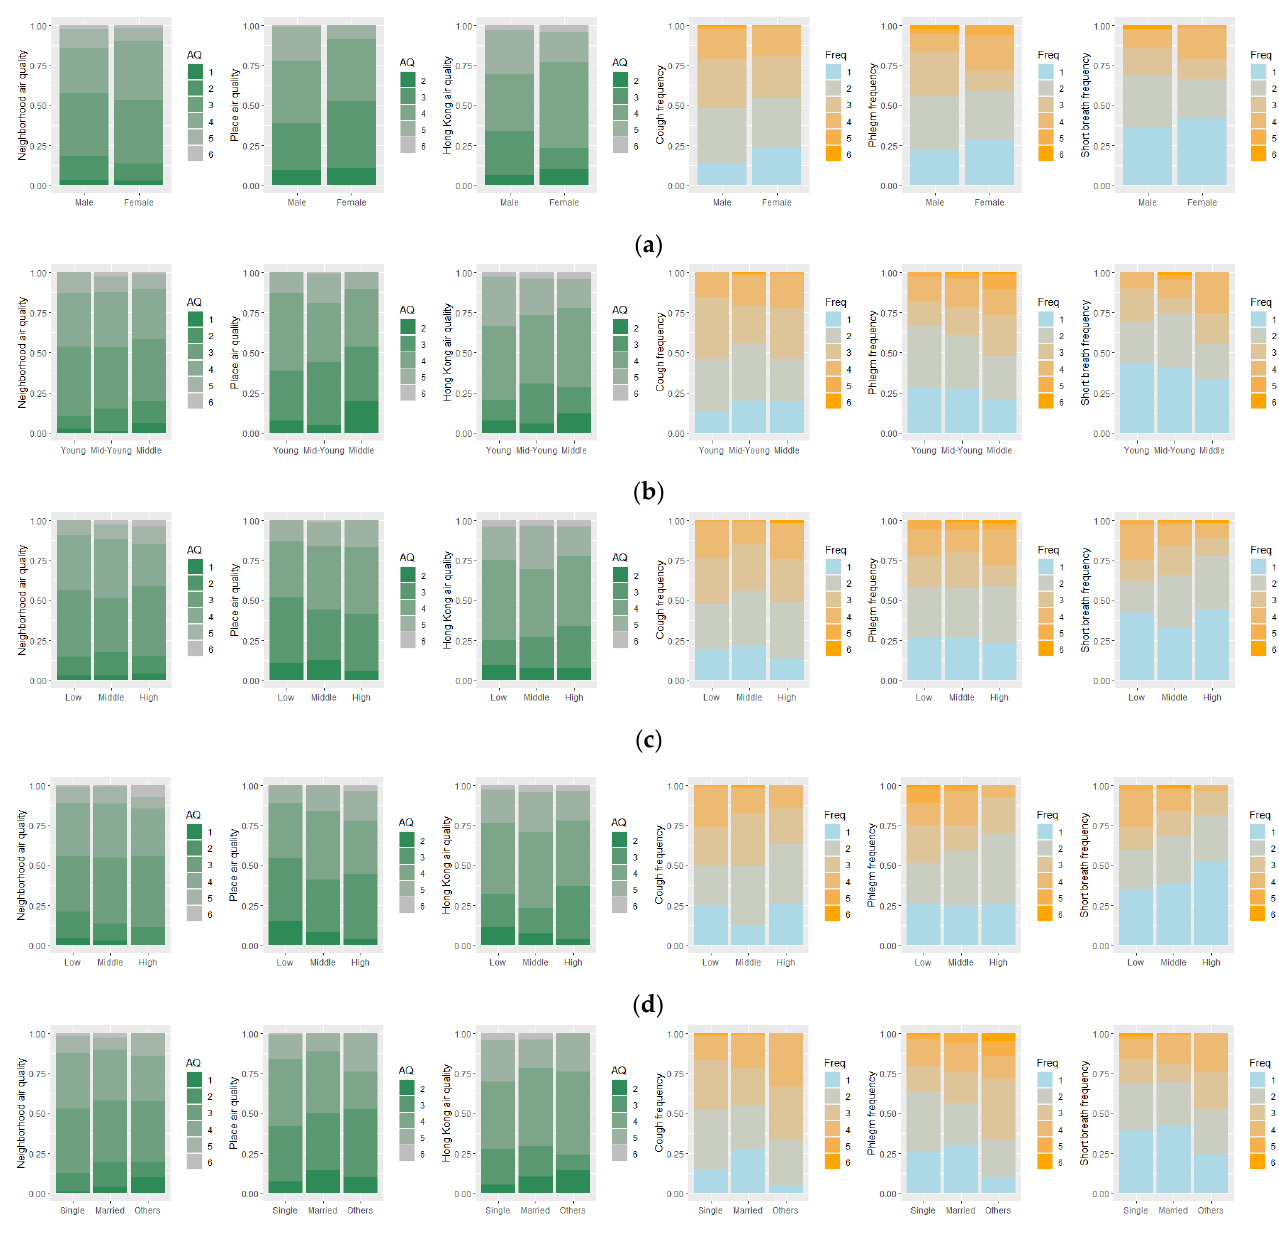
Figure 2. Distribution of participants’ perceived air quality and their self-reported respiratory symptoms regarding different socio-demographic axes: ( a ). gender, ( b ). age, ( c ). monthly household income, ( d ). education level, and ( e ). marital status. AQ is short for air quality.